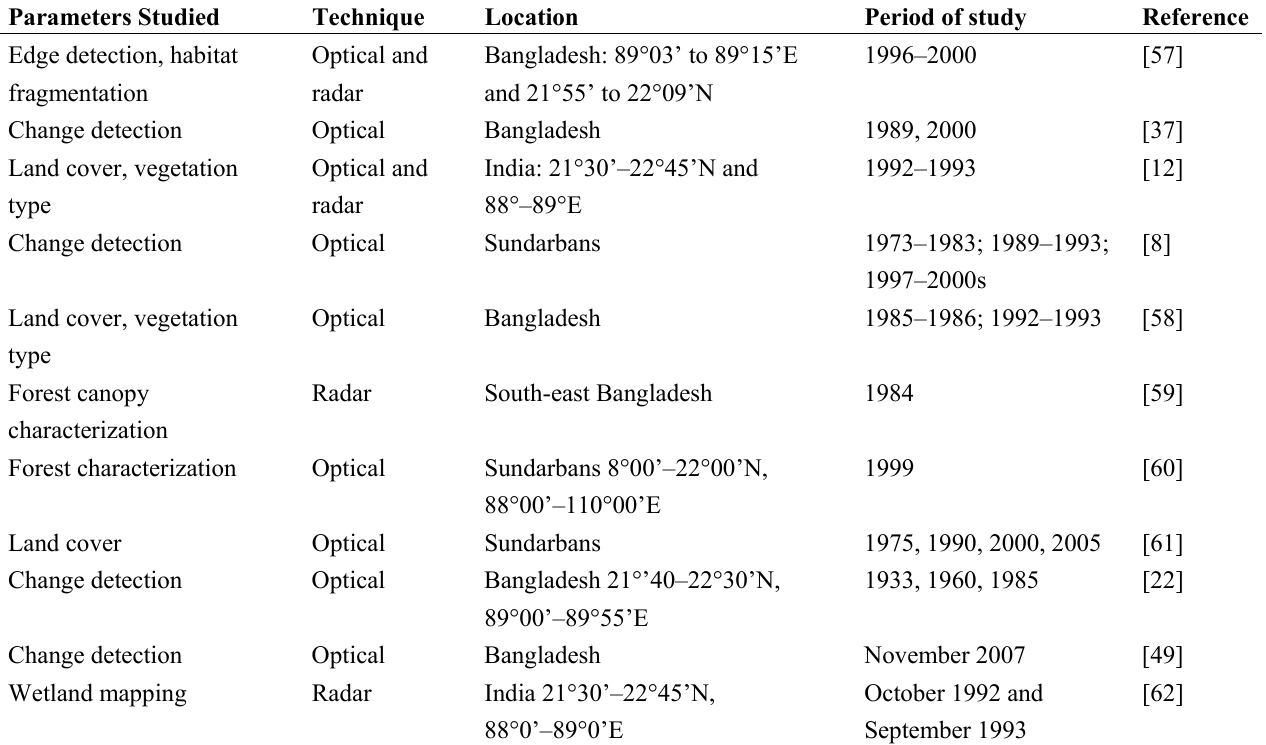
Table 1. Overview of previous remote sensing based research on the